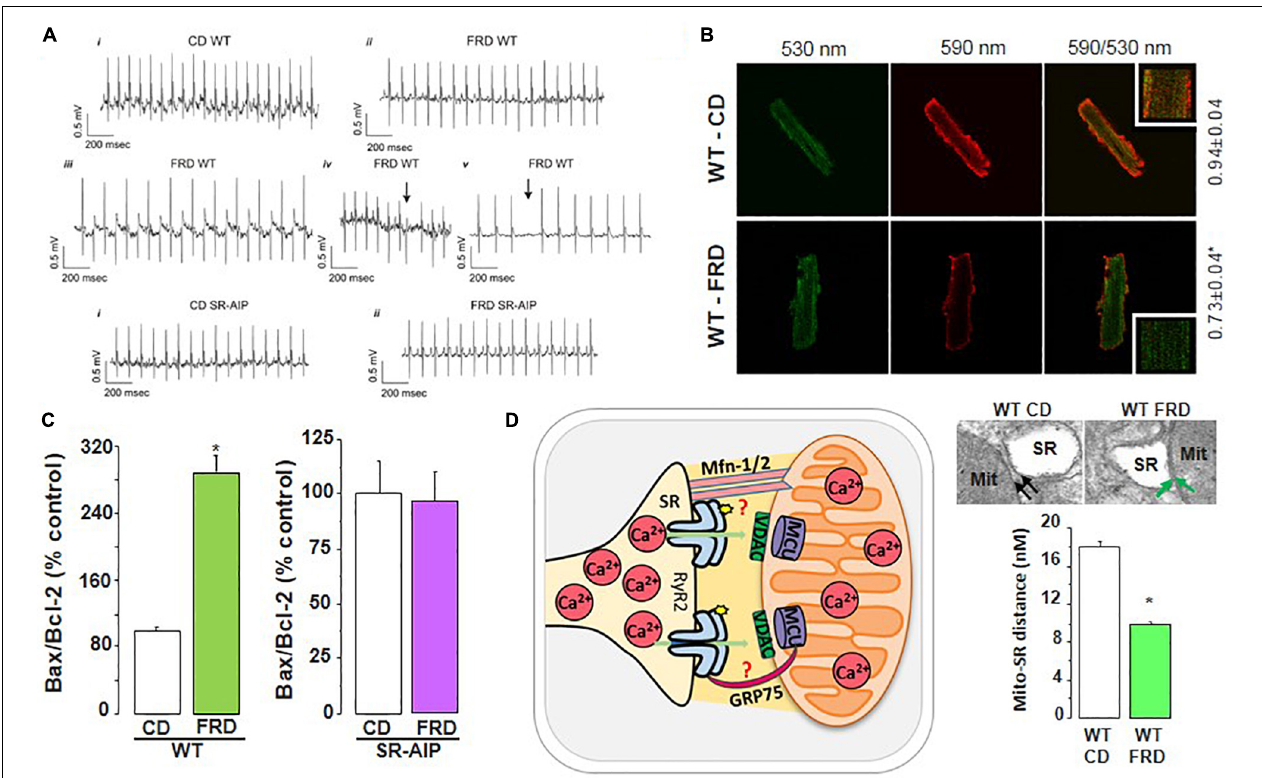
FIGURE 8 | RyR2 dysregulation in DCM development. (A) Representative ECG recordings showing that fructose-rich diet (FRD) induces cardiac arrhythmias in WT but not in SR-AIP mice (CD, control diet). WT mice exhibit bradycardia (ii), bidirectional tachycardia (iii), ventricular ectopic beats (iv, arrow), and AV block (v, arrow) when treated with FRD. (B) FRD deteriorates mitochondria membrane potential, as shown by an increase in JC-1 green/red fluorescence ratio. (C) This alteration in FRD mitochondria is in accordance with a higher apoptotic ratio (Bax/Bcl-2 proteins), which can be prevented in mice expressing the CaMKII inhibitory peptide at the SR level (SR-AIP). (D) Histological samples (upper right) show a closer distance between mitochondria and SR in FRD vs. CD treated mice, which might be due to an alteration in structural proteins involved in SR-mitochondria communication. The cartoon in the left side of (D) represents this SR-mito interaction (reproduced with permission from Federico et al., 2017). * p <